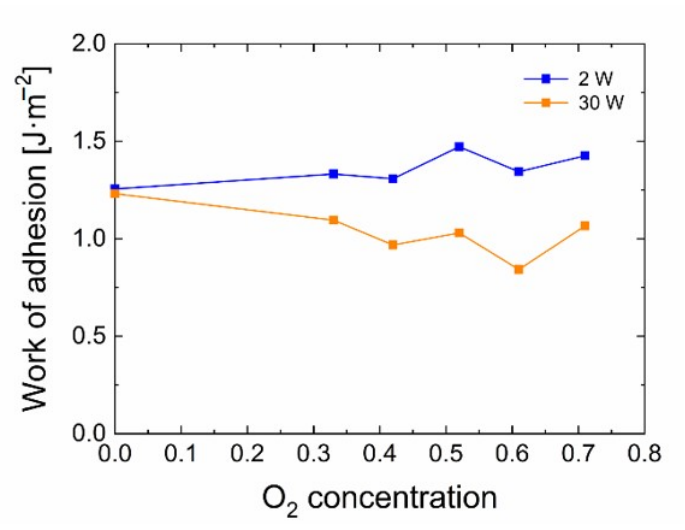
Figure 10. Calculated work of adhesion for the 2 W and 30 W sets of samples.